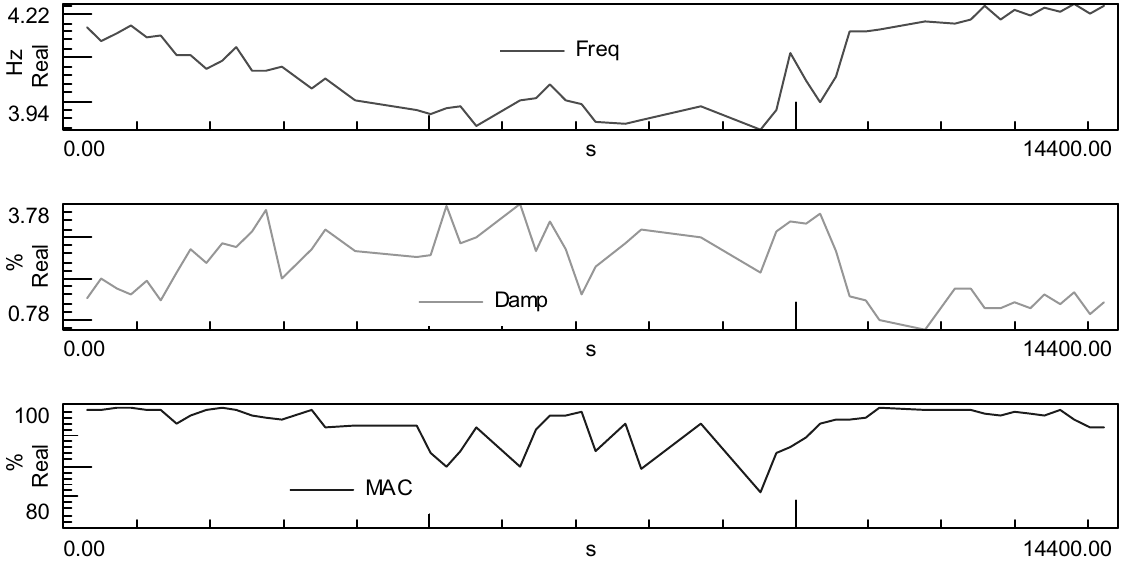
Fig. 16. Tracking of mode 3. (Top) Eigenfrequency; (Middle) Damping ratio (Bottom) MAC value between current and previous mode